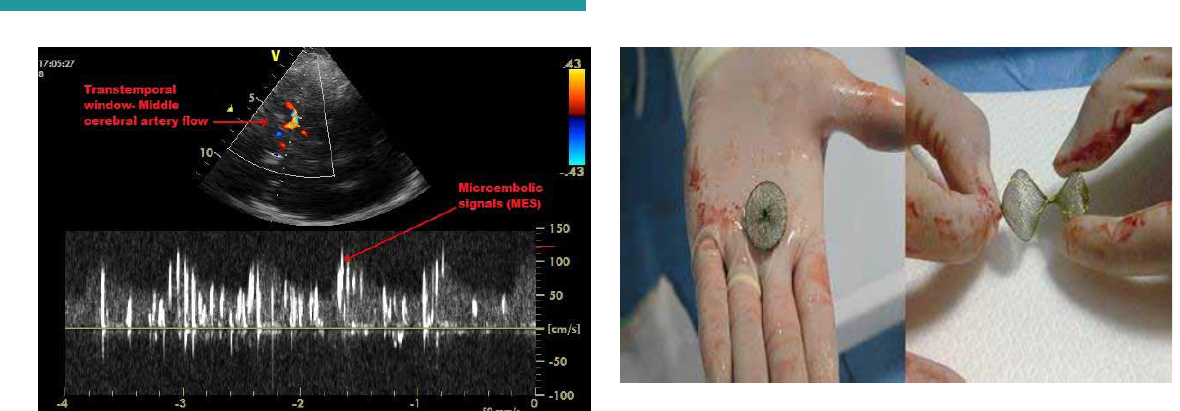
Figure 3. Figulla® Flex Occlutech device.